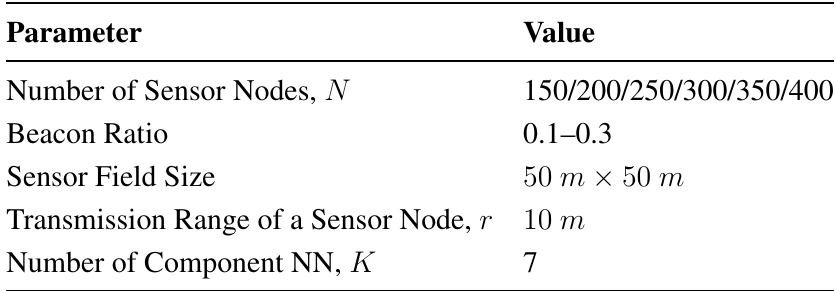
Table 1. Simulation Parameters.